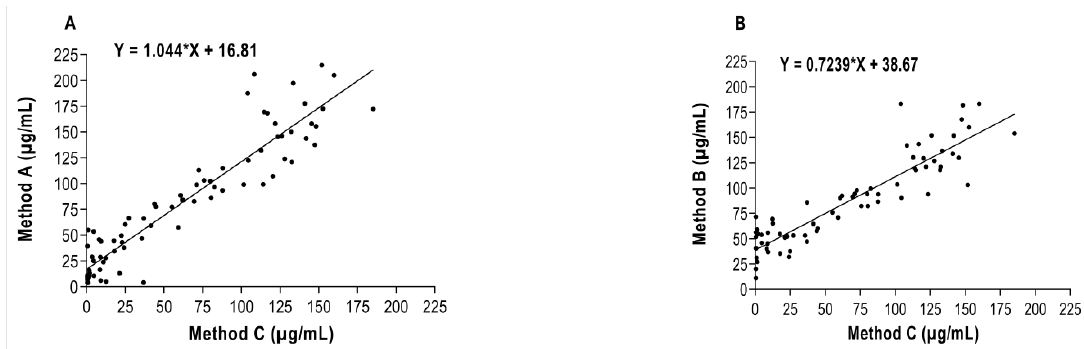
Figure 1. Correlation study of serum samples concentrations between: ( A ) Fujifilm (method A) and Eiken (method C) and ( B ) between Eurolyser Diagnostica (method B) and Eiken (method C).